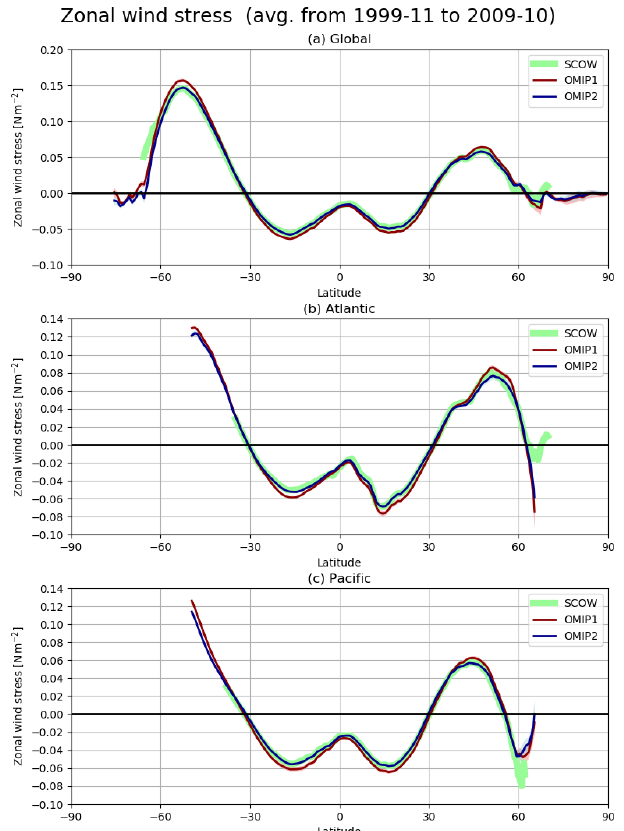
Figure 17. Multi-model mean, 20-year (1988–2007) mean north- ward heat transport (PW = 10 15 Wm − 2 ) in three oceanic basins. (a) Global, (b) Atlantic–Arctic, and (c) Indo-Pacific Ocean basins. Multi-model mean (lines) and spread defined as 1 standard devia- tion of the ensemble (shades) of OMIP-1 (red) and OMIP-2 (blue). For reference, implied northward heat transport derived from CORE (orange) and JRA55-do (green) dataset using sea surface tempera- ture from COBE-SST (Ishii et al., 2005) as the lower boundary con- dition is depicted as in Tsujino et al. (2018). The open circles are estimated from observations and assimilations complied by Mac- donald and Baringer (2013). The cross at 26.5 ◦ N in the Atlantic (b) is an estimation from RAPID transport array reported by McDon- agh et al. (2015). See Figs. S42 and S43 for results of individual